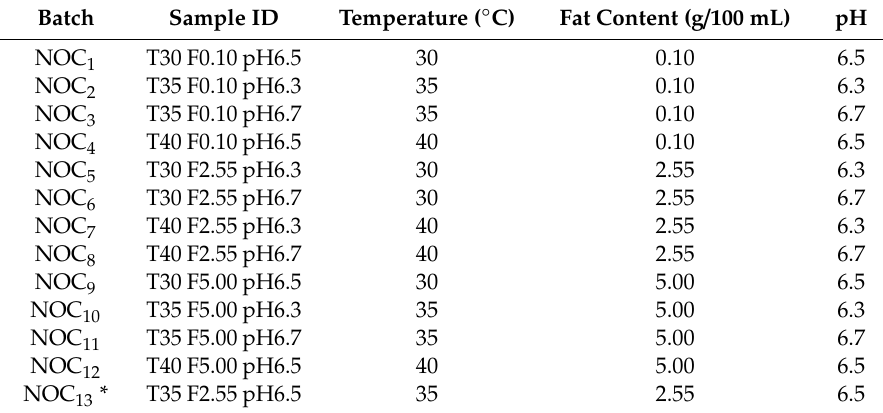
Table 1. Milk renneting batches set up under normal operating conditions (NOC) for the development of a process monitoring tool. * NOC 13 conditions were performed in three replicates (NOC 13a , NOC 13b , and NOC 13c